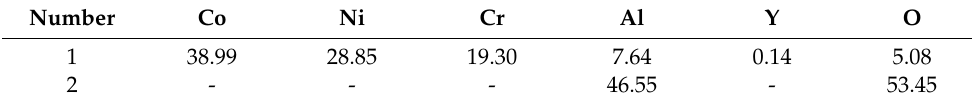
Figure 1. ( a ) Morphology of the CoNiCrAlY powder; ( b ) Cross-section morphology of the CoNiCrAlY powder; ( c ) Morphology of the CoNiCrAlY-Al 2 O 3 core-shell structured powder; ( d ) Cross-section morphology of the CoNiCrAlY-Al 2 O 3 core-shell structured powder. Table 4. EDS analysis results of the positions as marked in Figure 1d (at.%).